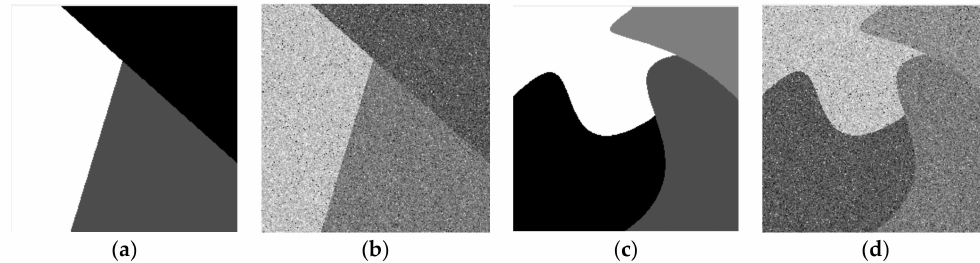
Figure 2. ( a ) Noise-free synthetic image 1; ( b ) synthetic image 1 polluted by synthetic noise; ( c ) noise-free synthetic image 2; ( d ) synthetic image 2 polluted by synthetic noise.